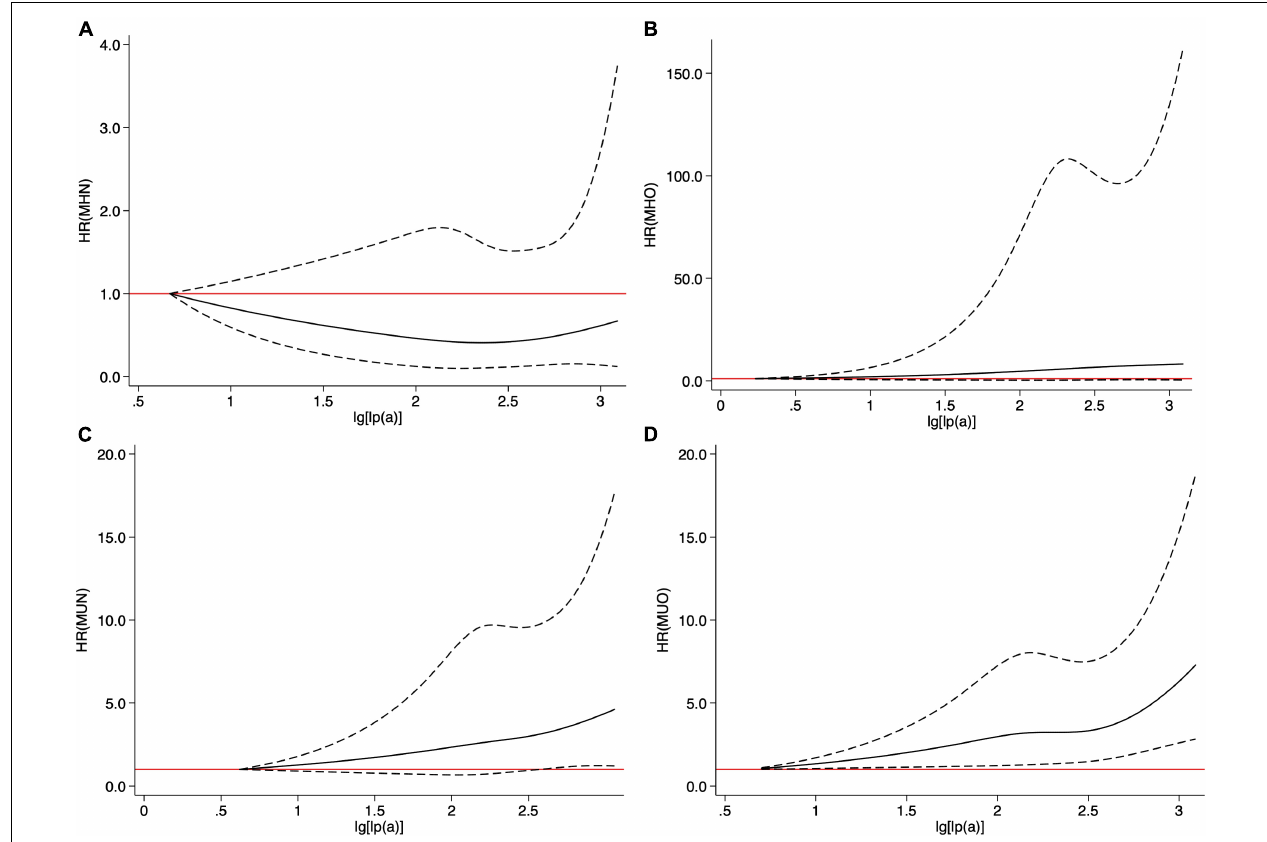
FIGURE 3 | Cubic spline models of Lp(a) in four metabolic phenotypes (A) metabolically healthy non-obese (MHN), (B) metabolically healthy obesity (MHO), (C) metabolically unhealthy non-obese (MUN), and (D) metabolically unhealthy obesity